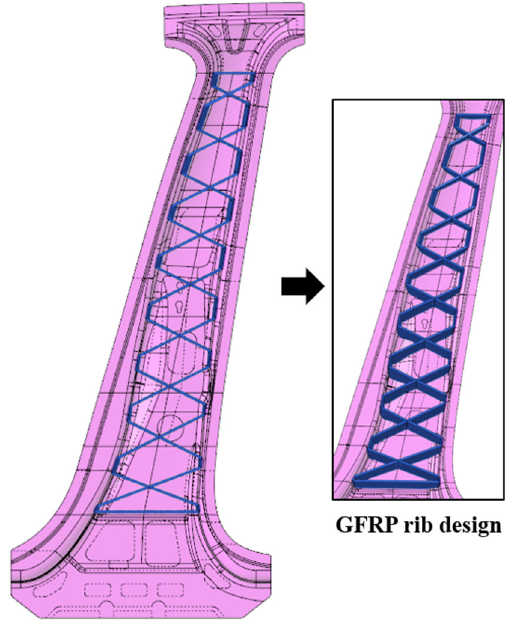
Figure 11. GFRP rib design with topology optimization results.